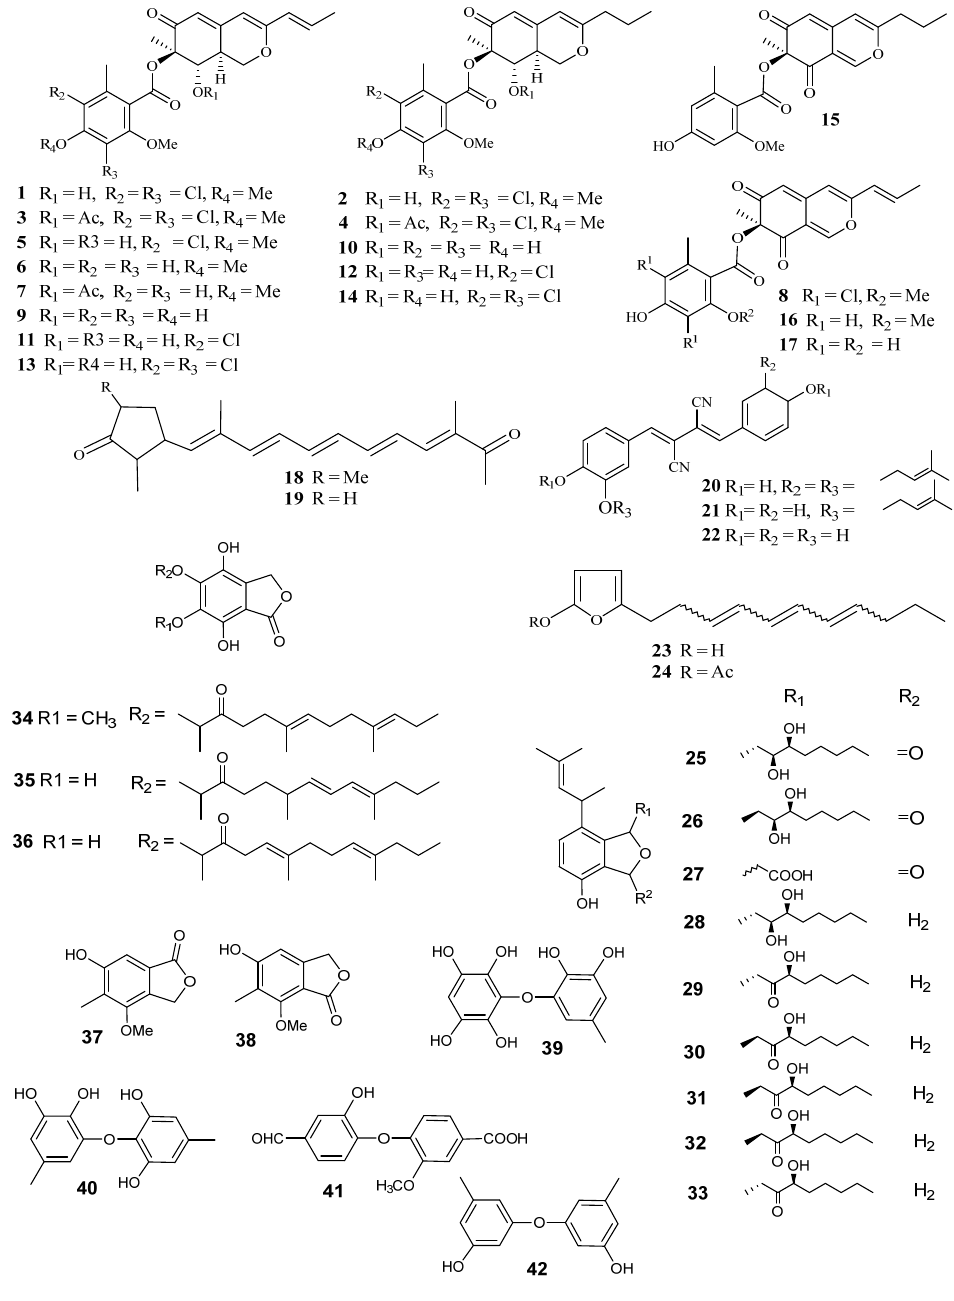
Figure 2. Structures of compounds 1–42.